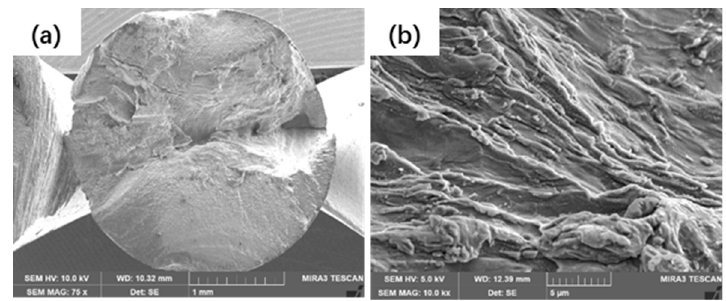
Figure 10. ( a ) The macroscopic morphology of the fatigue fracture, and ( b ) morphology of the fatigue fracture.